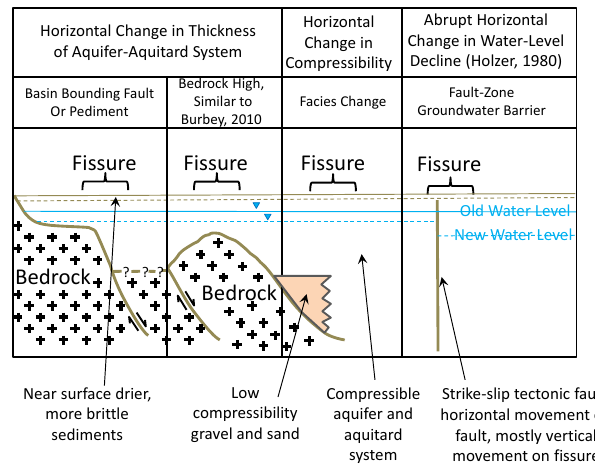
Figure 6. Schematic of differential compaction settings for earth fissures.